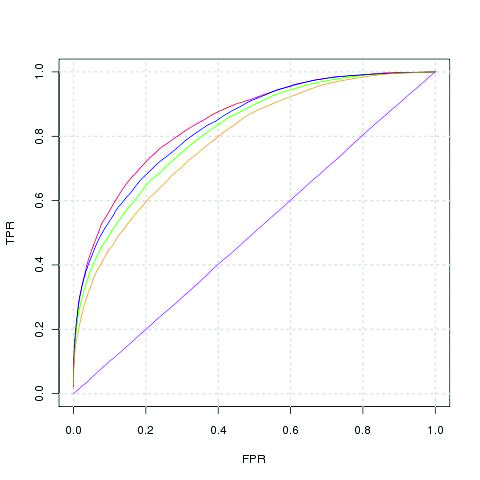
ROC curves combining structure, energy, conservation and B-factors information and different environment definitions. Red, green, blue and yellow lines represent ROC curves using VDs, sphere, sliding window, and single residues (i.e. no environment) as environment descriptors respectively. Purple line represents a random prediction.